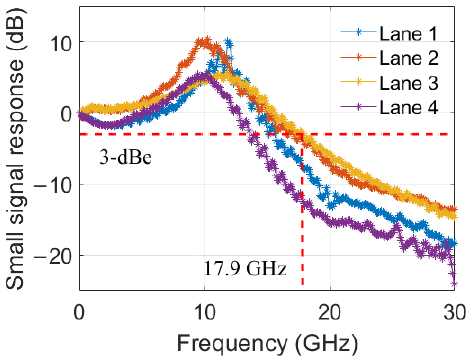
Figure 5. Small-signal frequency responses of the LC-DFB laser array with injection currents of 100 mA at 10 °C.